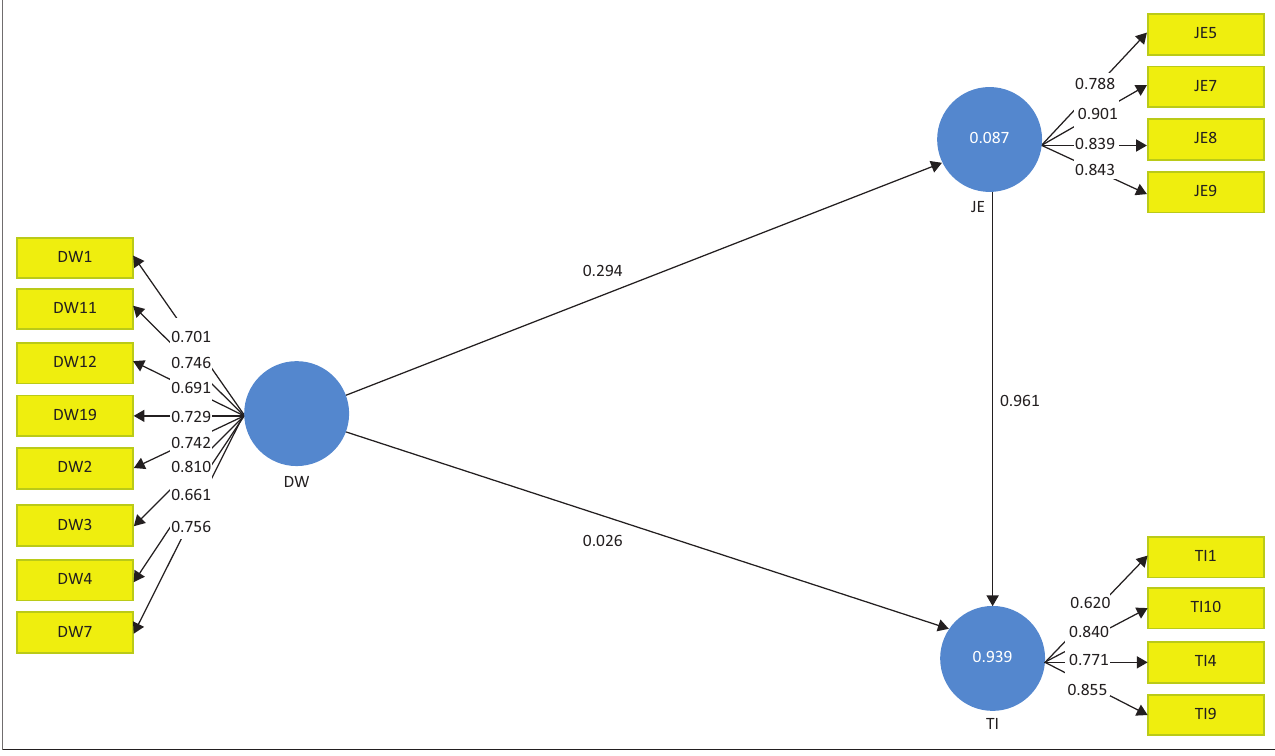
decent work; JE, job engagement; TI, turnover intention. FIGURE 2: Relationships in the goodness of fit TABLE 5: Goodness of fit results. SRMR NFI 0.073 0.915 SRMR, standardized root mean square residual; NFI, Normed Fit